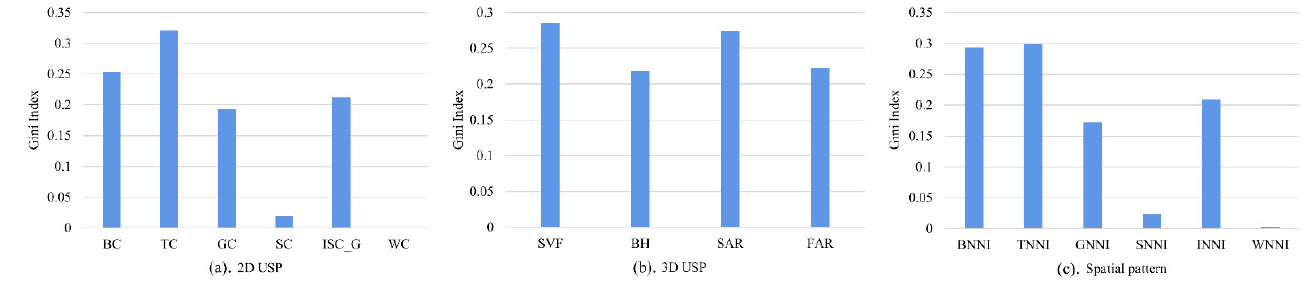
Figure 9. The variable importance of 2D USPs, 3D USPs, and spatial patterns of land covers. Figure 10 shows the changes in the OA value with different input variables. As shown, the OA value increased rapidly when the number of variables changed from 1 to 4, and it reached the highest accuracy of 91.9% when the number of input variables was 14. Therefore, the 14 variables of the optimal combination were selected to perform the